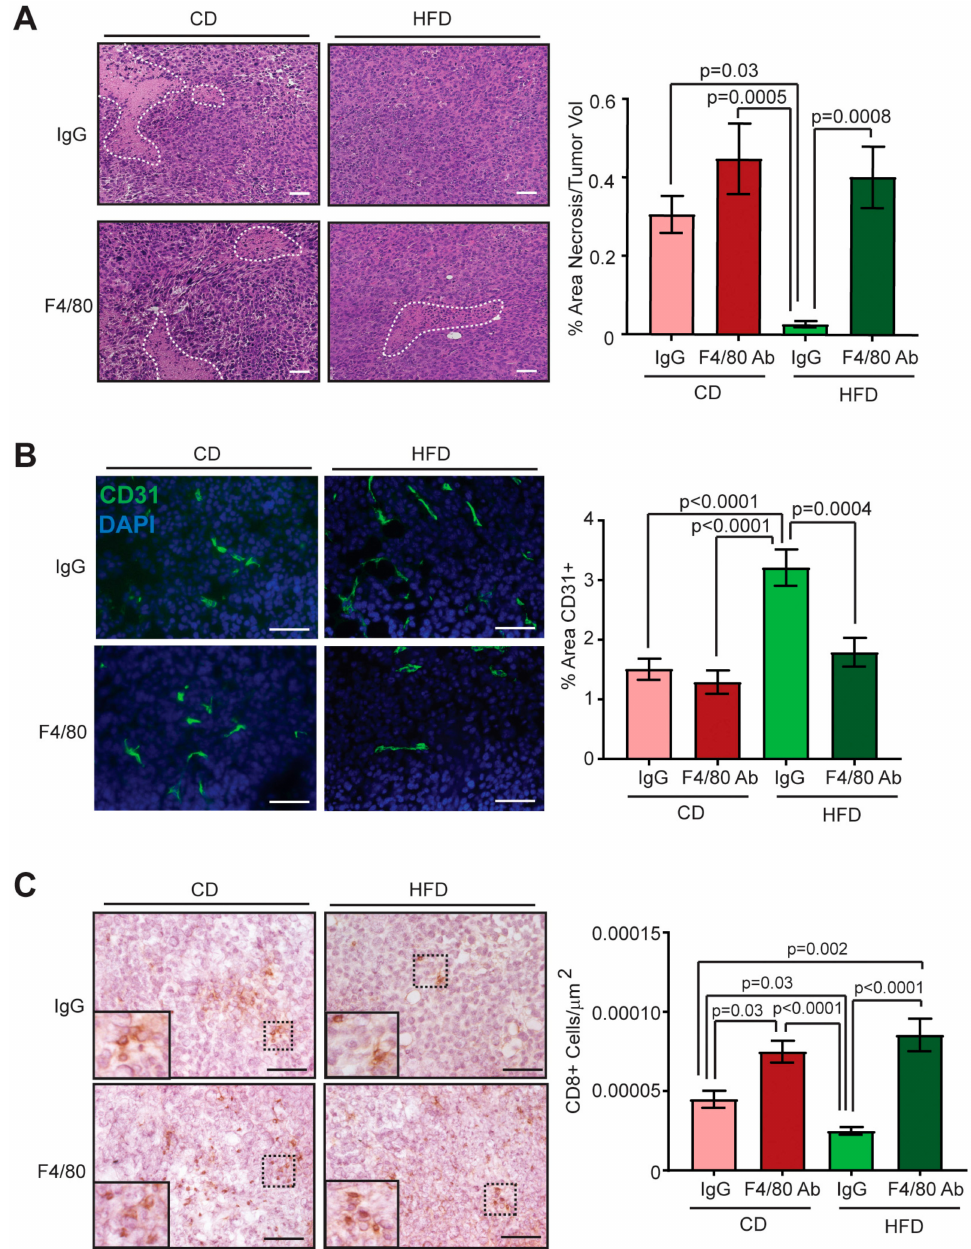
Figure 5. Depletion of macrophages in obese mice abrogates obesity-induced angiogenesis. ( A ) Percent necrotic area was quantified from tumor sections ( n = 3–4 / group; two-way ANOVA with Tukey’s multiple comparison test). An interaction between the variables of obesity and macrophage-depletion was observed ( p = 0.06). ( B ) CD31 expression was detected using immunofluorescence in tumors from each group ( n = 3–4 / group; two-way ANOVA with Tukey’s multiple comparison test). a significant interaction between the variables of obesity and macrophage-depletion was observed ( p = 0.02). ( C ) CD8 + T cells were quantified from tumors using immunohistochemistry ( n = 3–4 / group; two-way ANOVA with Tukey’s multiple comparison test). a significant interaction between the variables of obesity and macrophage-depletion was observed ( p = 0.007). Bars represent mean ± s.e.m. Magnification bars = 50 µ